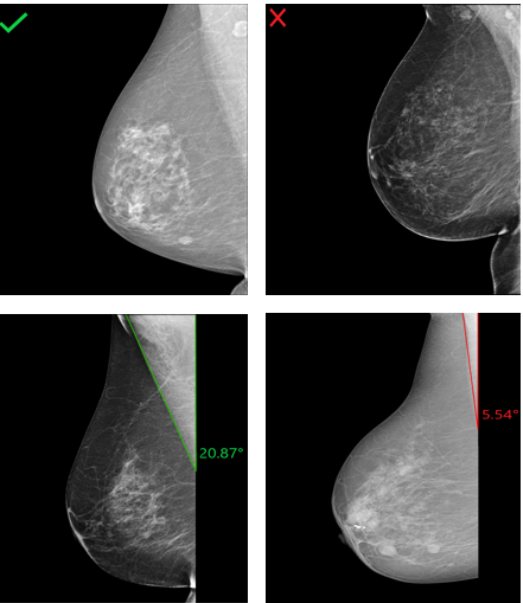
Figure 16. Assessment of the pectoralis muscle angle in four different R-MLO views. ( Left ): Mammo- grams with correct pectoralis muscle angle. ( Right ): Inadequate positioned mammograms due to convex pectoralis muscle (above) and angle <10°